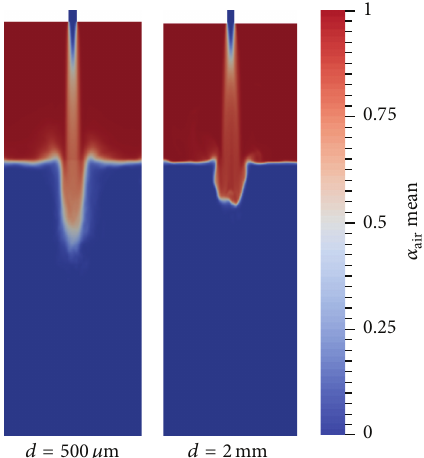
Figure 7: Time-averaged void fraction profile obtained using two different constant diameters: 𝑑 = 500 𝜇 mand 2mm and no interface